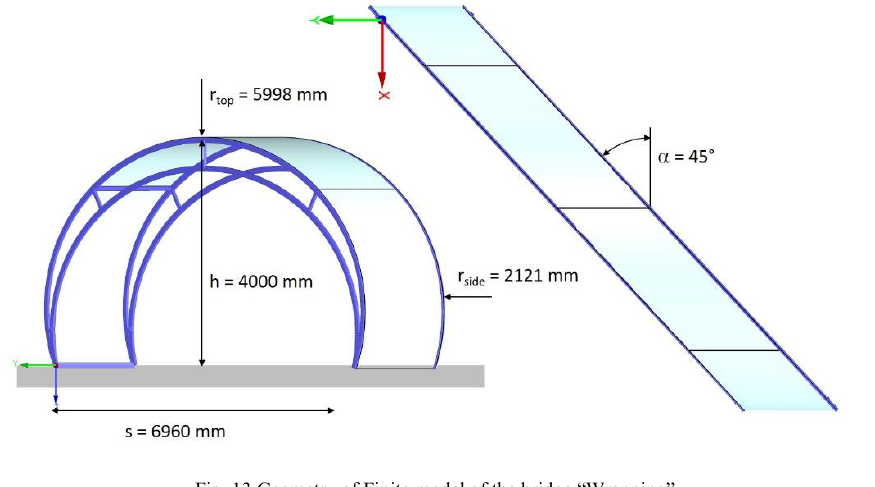
Fig. 13 Geometry of Finite model of the bridge